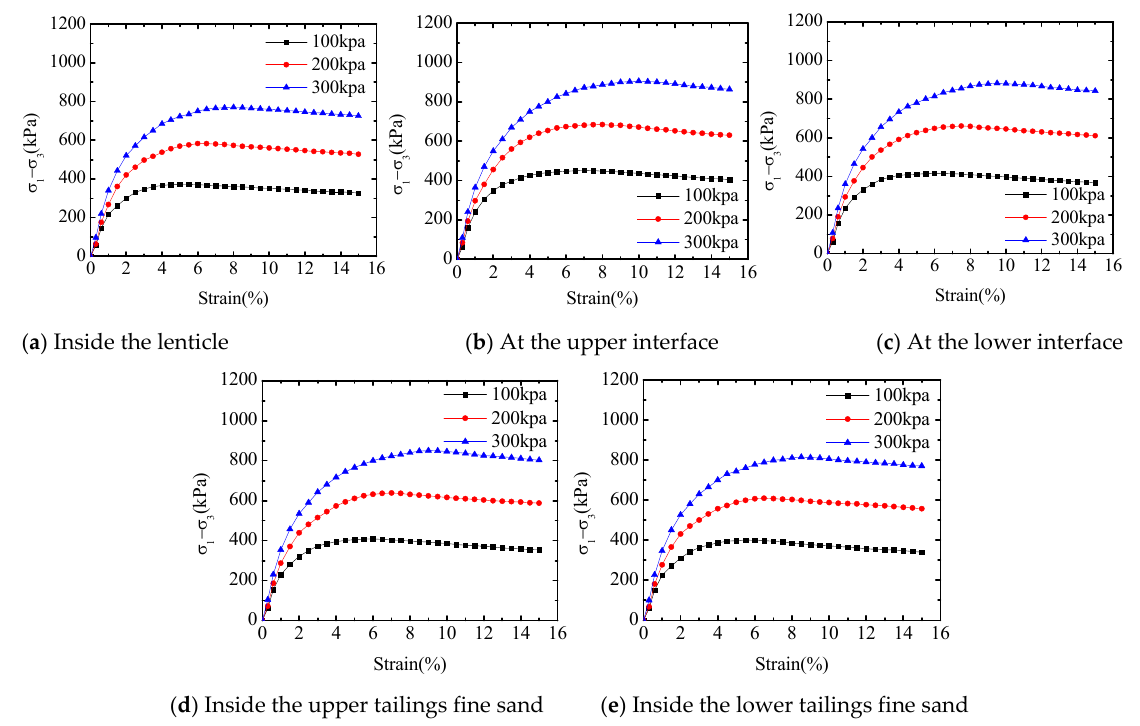
Figure 6. Deviatoric stress-strain curves of reinforced soil under different confining pressure, n = 1. ( a ) Inside the lenticle, ( b ) At the upper interface, ( c ) At the lower interface, ( d ) Inside the upper tailings fine sand, ( e ) Inside the lower tailings fine sand.